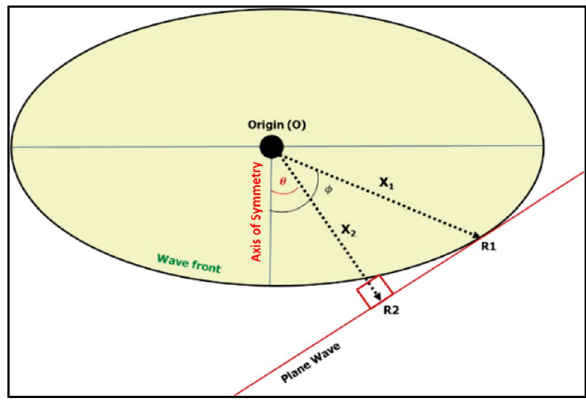
Fig. 3 Difference between the phase and group velocity. The distance from the origin (o) to R1 and R2 point is different, so the phase and the group velocities will be